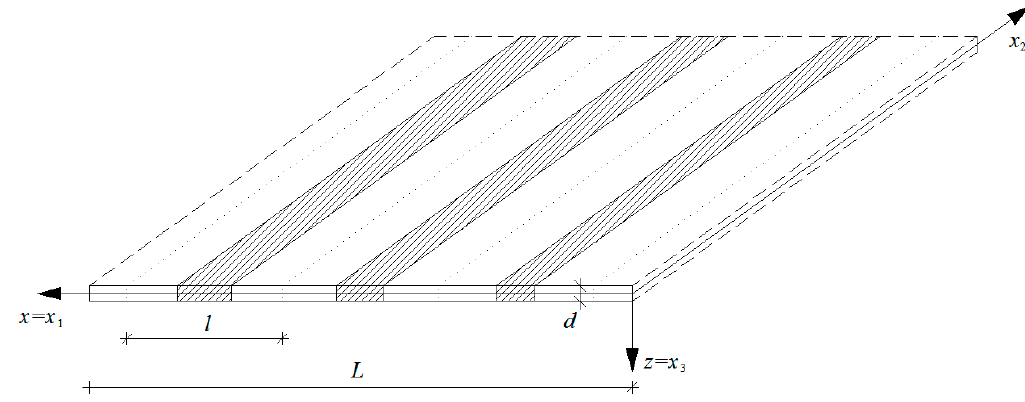
Figure 2. A part of a microstructured functionally graded plate band.